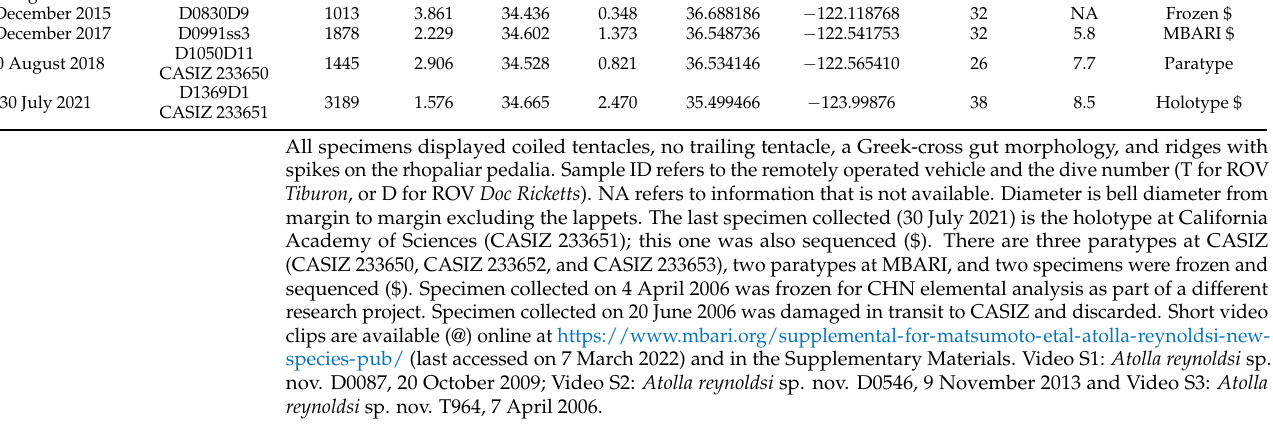
Table 3. Physical measurements and water parameters for the collected specimens of Atolla species A.